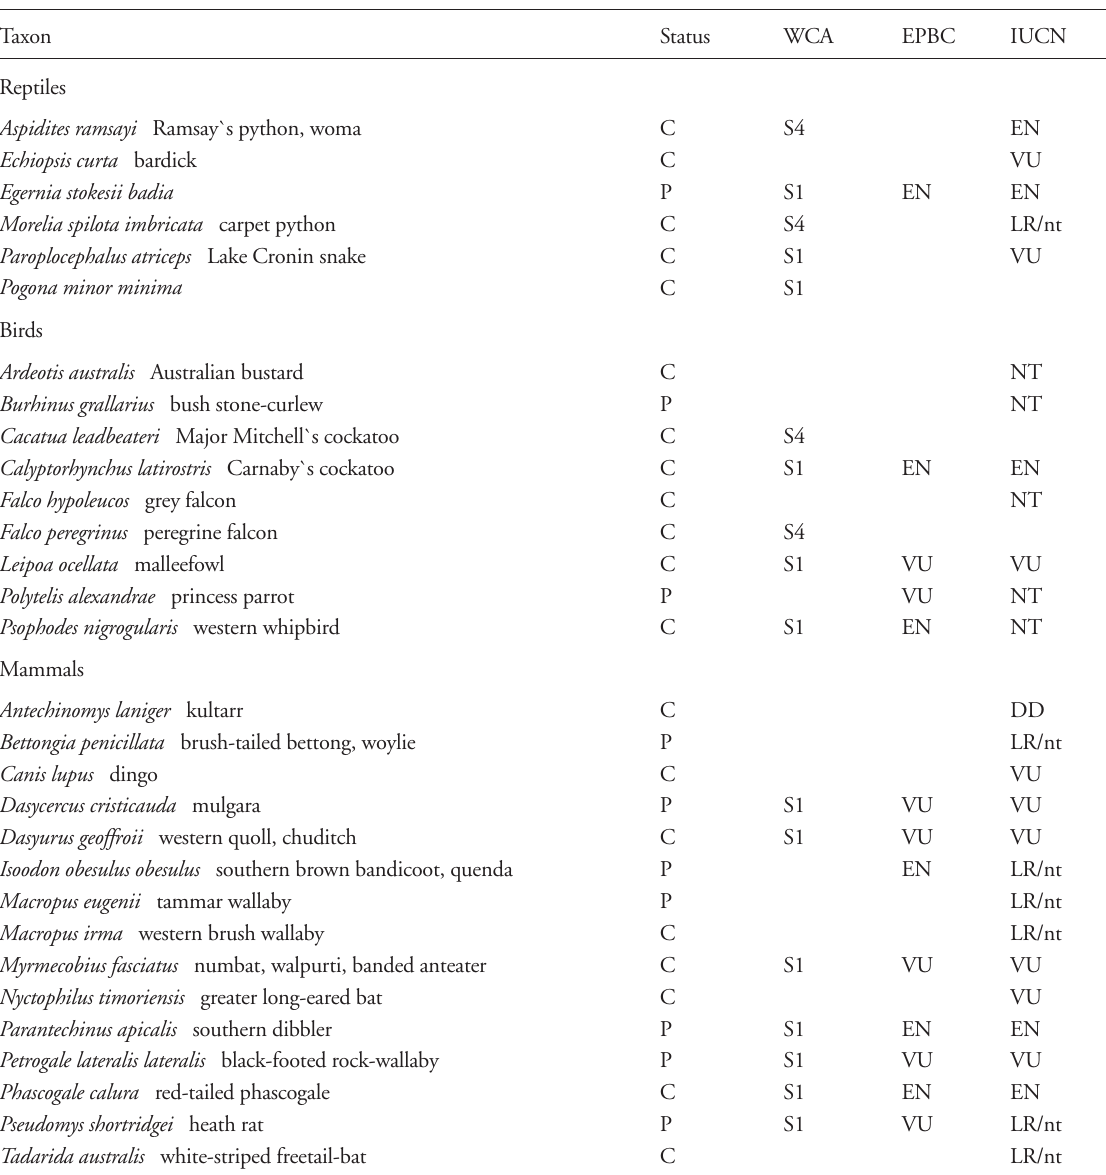
Table 1.Vertebrate species that are known to occur (C) or possibly occur (P) in the study area that are listed under the Western Austral- ian Wildlife Conservation Act 1950 (WCA), the Commonwealth of Australia Environment Protection and Biodiversity Conservation Act 1999 (EPBC) or in the IUCN Red List of Threatened Species 2006 (IUCN). WCA: S1 = fauna that is rare or likely to become extinct; S4 = other specially protected fauna. EPBC: EN = endangered; VU = vulnerable. IUCN: EN = endangered; VU = vulnerable; DD = data deficient; LR/nt = lower risk/near threatened (not strictly threatened